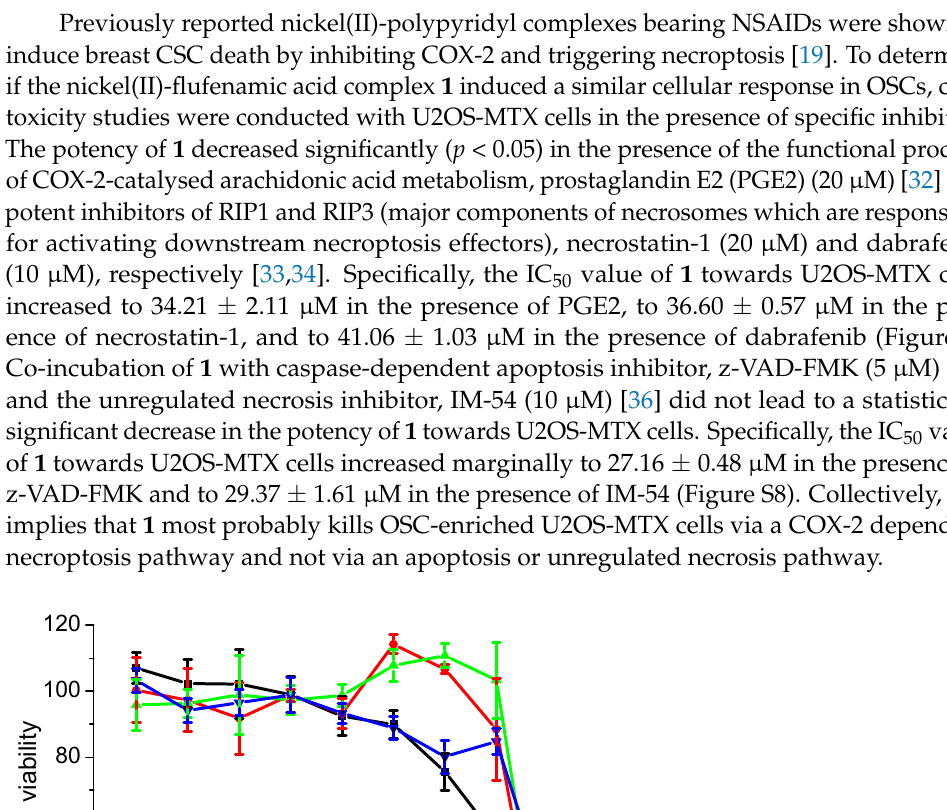
Figure 3. Representative bright-field images (×10) of U2OS-MTX osteospheres formed from single cell suspensions of U2OS-MTX cells without and with the addition of 1 or flufenamic acid (IC 20 values) after 10 days incubation. Scale bar = 200 µm.